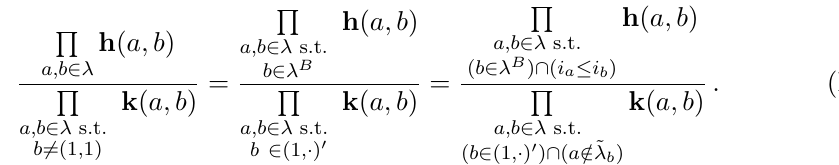
Figure 7. The green highlighted boxes forming